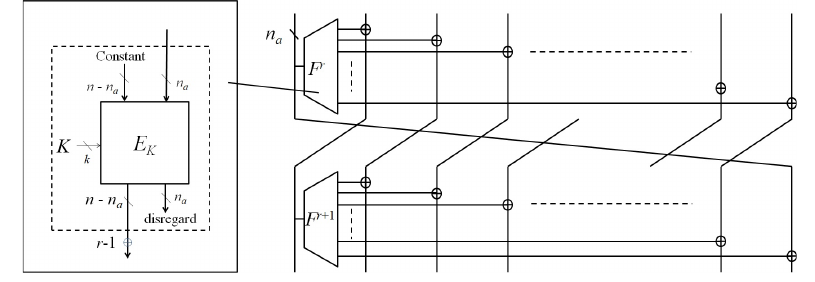
Figure 1: Overview of SPACE